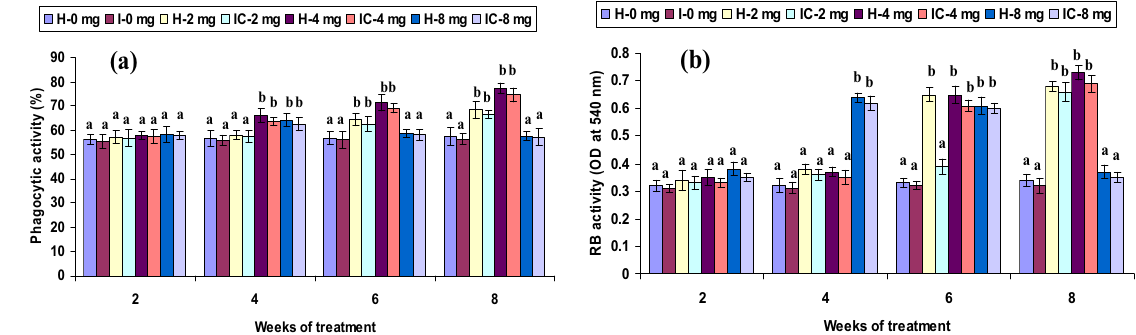
Figure 1. ( a ) Phagocytic activity and ( b ) respiratory burst (RB) activity of catla (n = 6) head kidney leucocytes against A. hydrophila . H healthy, I infected. Data are expressed as mean ± SD and the statistically significant difference ( P < 0.05) between mean values as indicated in different letters in each column.